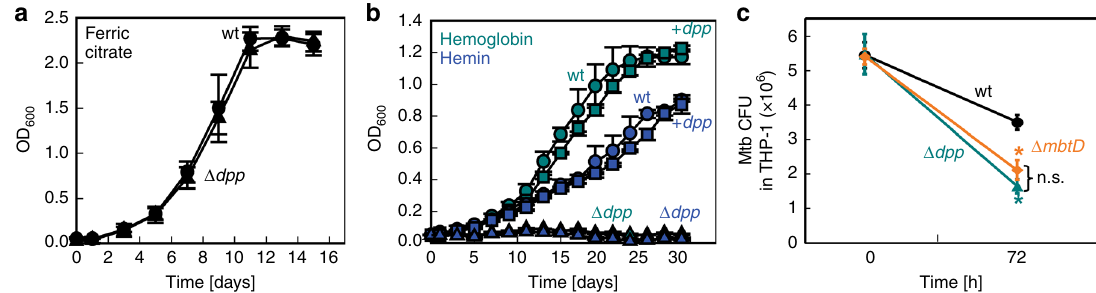
Fig. 7 M. tuberculosis survival in macrophages depends on heme and iron utilization. Growth of Mtb H37Rv (wt; circles), the Δ dpp mutant ML2437 (triangles), and the complemented Δ dpp mutant (squares) in HdB minimal medium with a 10 µ M ammonium ferric citrate and b 2.5 µ M human hemoglobin (cyan) or 10 µ M hemin (blue). c THP-1 cells were differentiated with phorbol myristate acetate (PMA) and infected at an MOI of 10 with wt Mtb H37Rv (black) and the Δ mbtD (orange) and Δ dpp (cyan) mutant strains. Survival of the Mtb strains in macrophages was determined by plating on agar plates and counting colony-forming units (CFU). Asterisks denote signi fi cant differences as determined by Tukey ’ s HSD following an F -test ( p < 0.05) compared to wt. n.s.: not signi fi cant. Error bars represent standard errors of mean values of biological triplicates. Source data are provided in the Source Data fi le